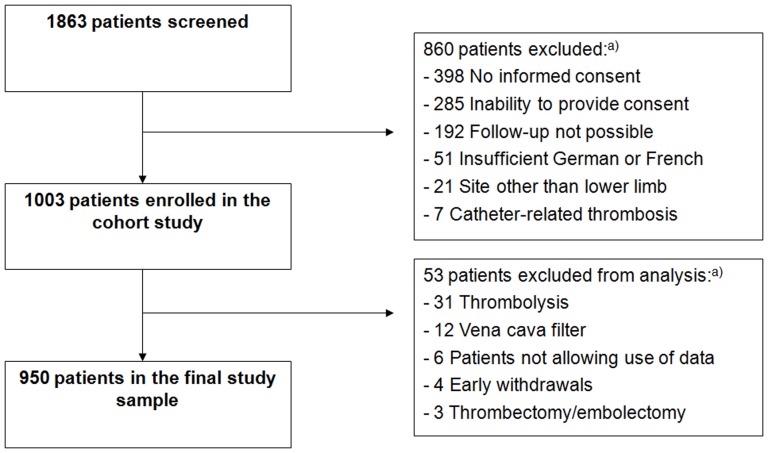
Flow chart.Abbreviations: DVT = deep vein thrombosis. A) Multiple reasons for exclusion may apply.